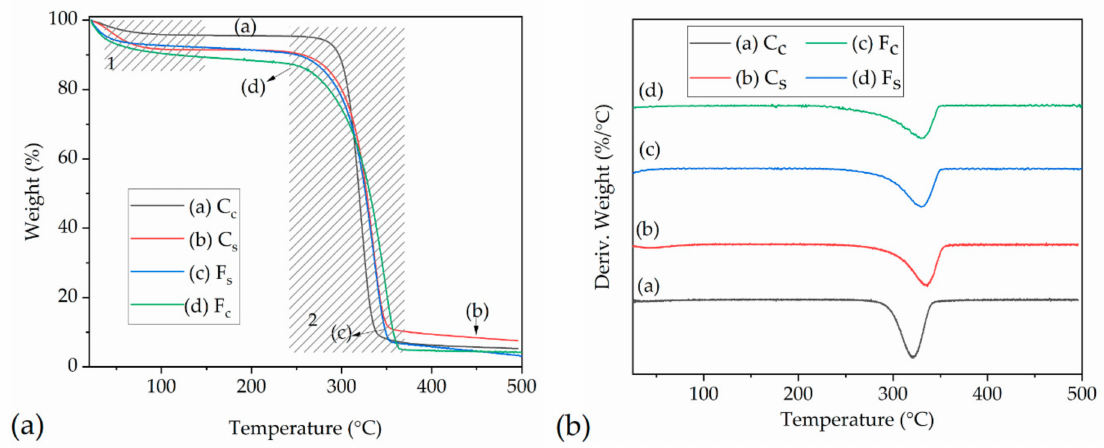
Figure 4. ( a ) TGA graphs of the cellulose powder S (C c , (a), black), cellulose powders type C (Cs, (b), red) and aerogel fibers type S (F s , (c), blue) and type C (F c , (d), green). The first step from 40 to 110 ◦ C in the mass loss was due to the evaporation of water molecules and the second step at elevated temperatures (from 255 to 360 ◦ C) happened due to the relatively fast decomposition of cellulose chains. ( b ) DTG curves show that the decomposing temperature of CA fibers compared to powders shifted toward a lower temperature and the maximal weight peak was